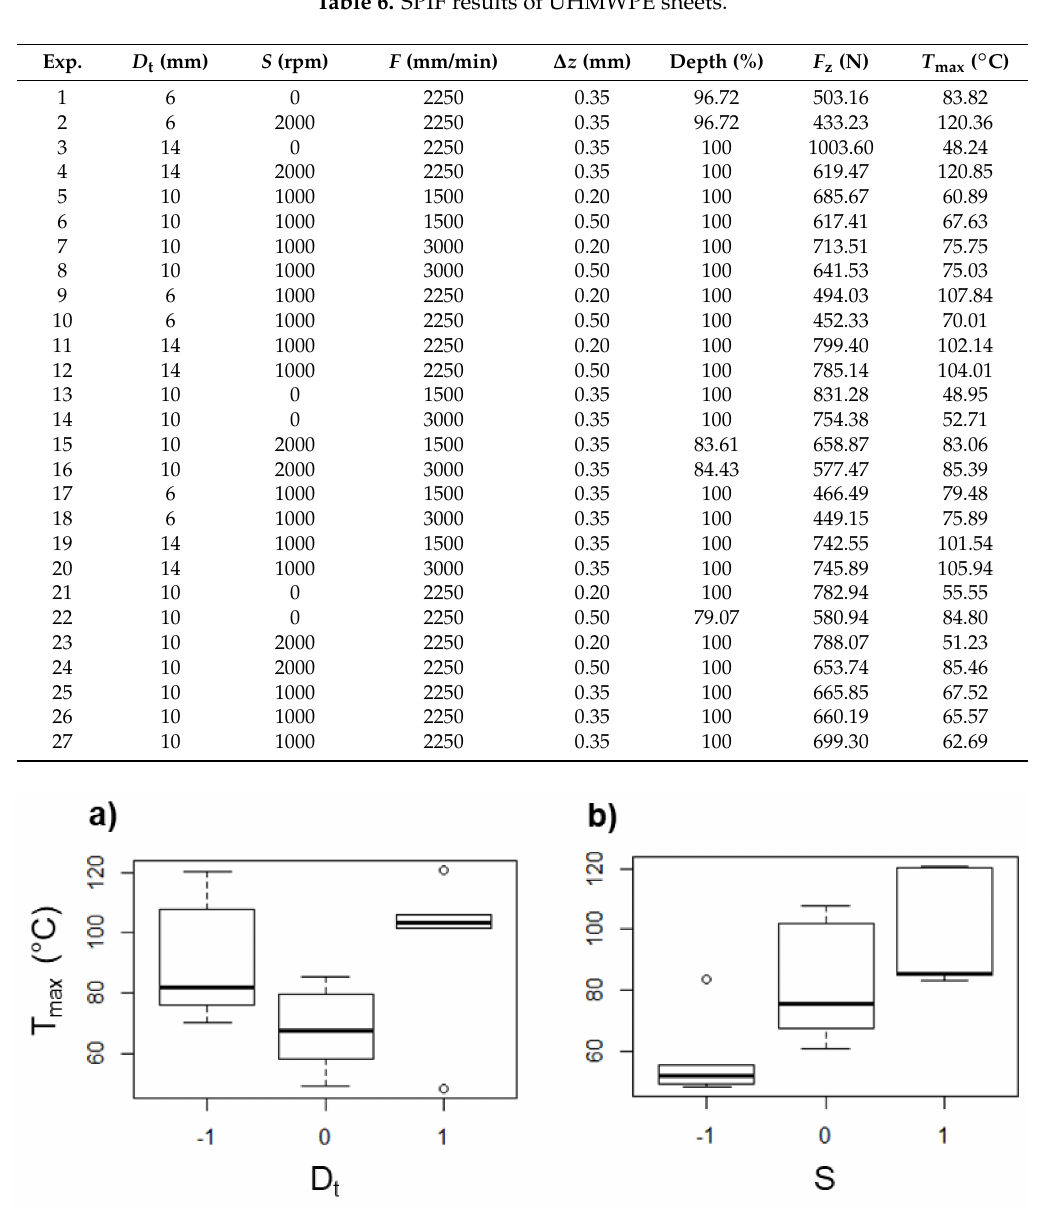
Figure 13. Box diagrams of T max (in ◦ C) for UHMWPE as a function of ( a ) D t and ( b ) S